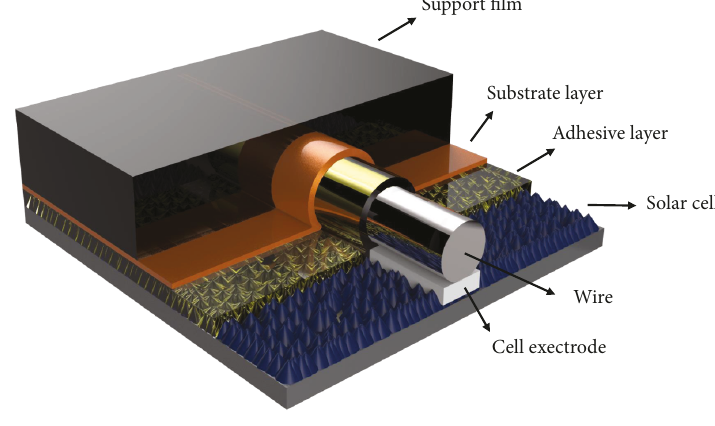
Figure 2: Cross section of the combined structure of a conductive belt and a cell.